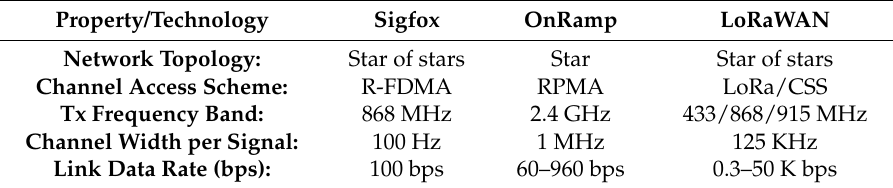
Table 3. Comparison of LTN technologies